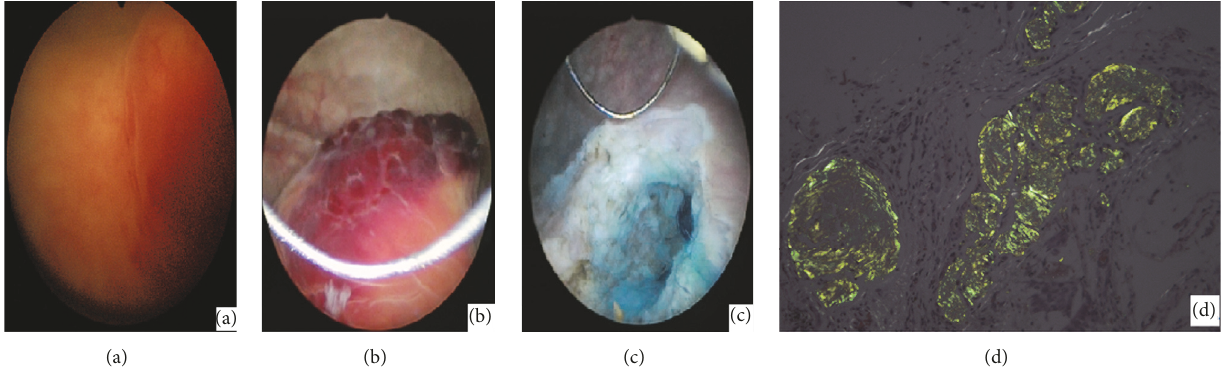
Figure1:(a)Preoperativeand(b,c)intraoperativecystoscopicfindingsofabnormalbladderlesions.(d)Depositsofamyloidmaterialshowing birefringence under polarized light (Congo red stain) ( ×